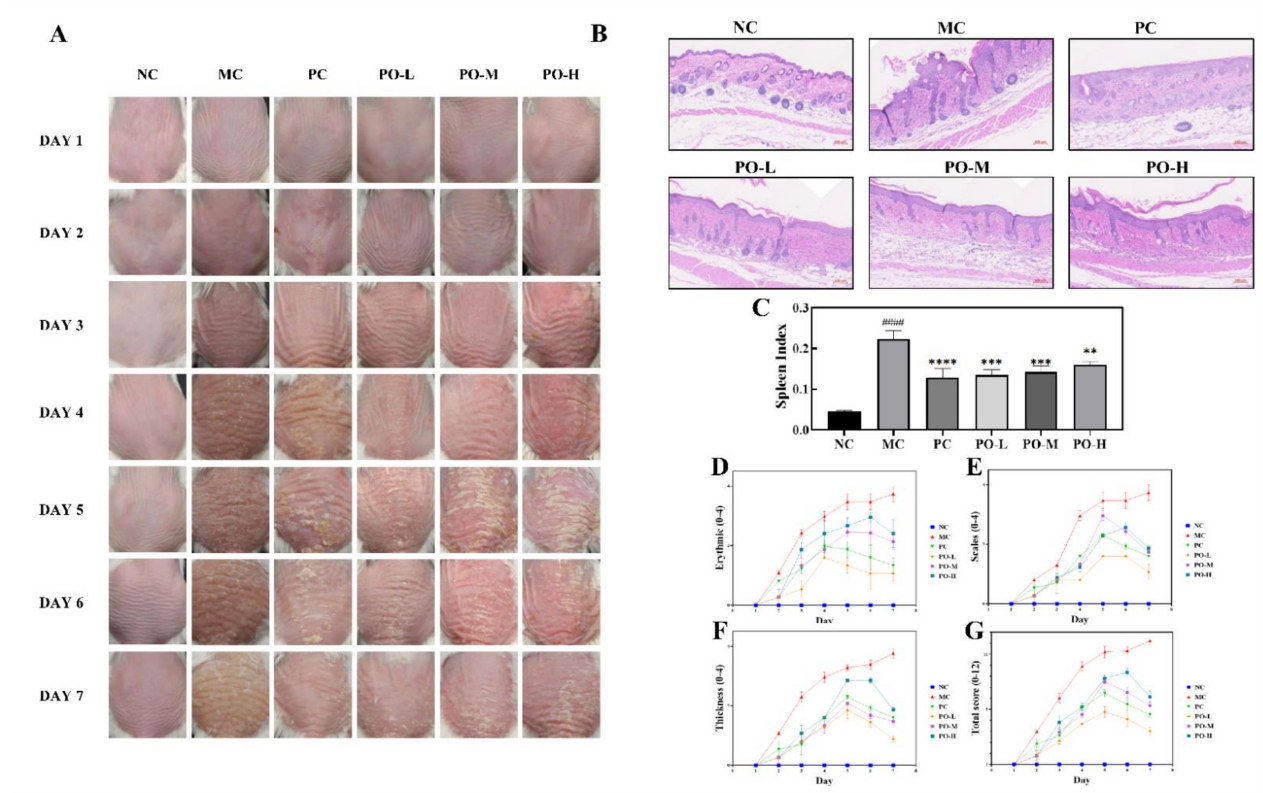
Figure 1. PO ameliorated imiquimod-induced psoriasis in BALB/c mice (PO, 0.01%, 0.5%, 1%, 60 mg/kg/d). ( A ) Skin changes record of BALB/c mice every day during the experiment. ( B ) H&E staining of BALB/c mice. ( C ) The spleen index of each group. The spleen index was calculated following the formula Spleen index = (spleen weight/mouse weight) × 10. ( D – G ) Erythema, scales, skin thickness, and total scores were evaluated daily based on the modified Psoriasis Area and Severity Index (PASI). Data are shown as mean ± SEM (n = 8), #### p < 0.0001 vs. NC group, ** p < 0.01, *** p < 0.001, **** p < 0.0001 vs. MC